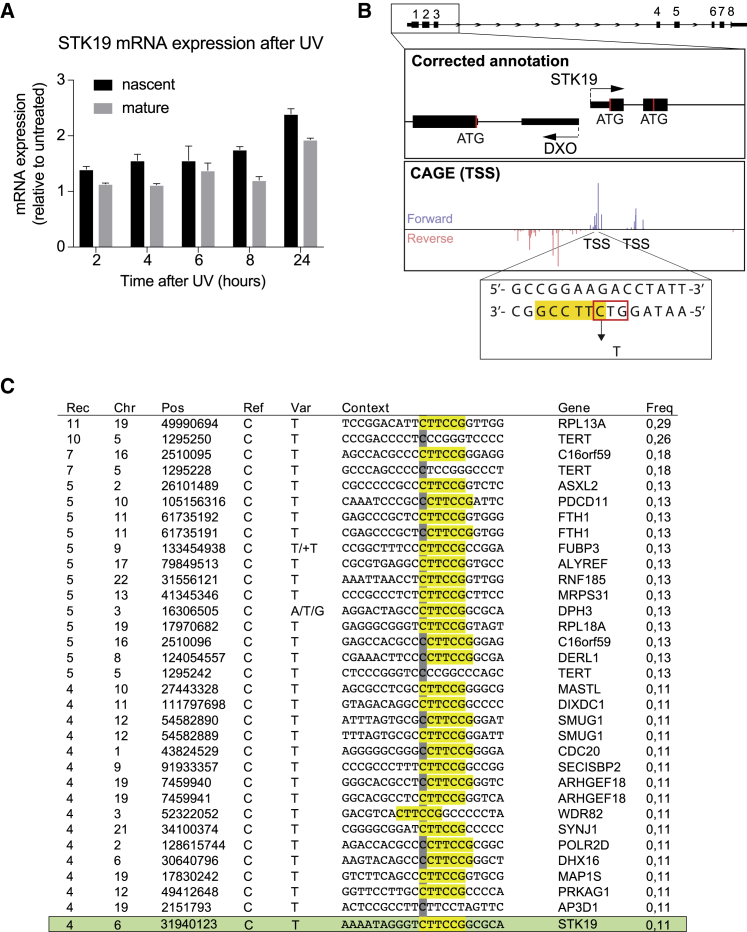
The “D89N” Mutation Is a Recurrent UV Signature(A) qPCR of STK19 expression after UV irradiation relative to untreated and normalized to GAPDH. Nascent and mature RNA are shown. Error bars represent ± SD. Statistically significant differences (p < 0.05, multiple t tests, Holm-Sidak correction) indicate there is not downregulation of the gene in any of the time points analyzed.(B) Diagram of STK19 gene 5′ region showing the corrected annotation aligned to CAGE (TTS) data and indicating the position of the “D89N” triplet mutation (red box). UV signature motif is underlined in yellow.(C) Table adapted from Fredriksson et al. (2017) showing all highly recurrent mutations within ± 500bp from TSS ordered by recurrence (number of mutated tumors). Based on the data used in Fredriksson et al. (2017), STK19 was analyzed and added as the last row to show the similarities with sequences reported in their work. Rec, recurrence of each mutation. Chr, chromosome location. Pos, position. Var, variant base. Context, sequence context, showing pyrimidine-containing strand with respect to the central mutated base (gray). The motif CTTCCG is highlighted in yellow. Gene, closest gene to the mutation. Freq, frequency of the mutation. Note that the TERT promoter mutation is also listed, although not in the same sequence motif, and that mutations in the TERT promoter have recently been found in benign skin nevi, arguing against a role of such mutation in cancer progression (Colebatch et al., 2019).